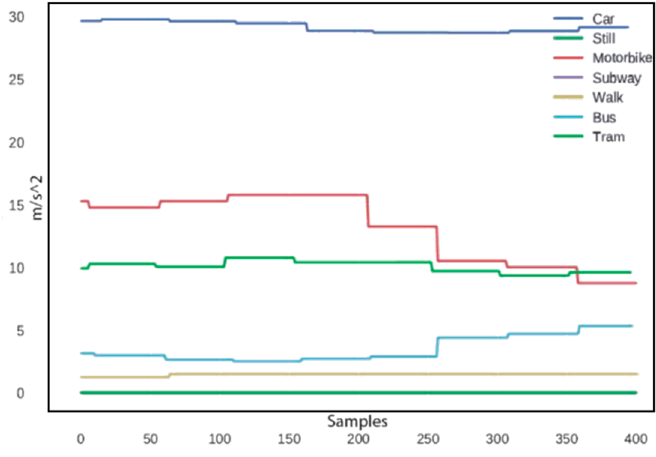
Figure 2. Velocity over 400 sampling times (8 s).